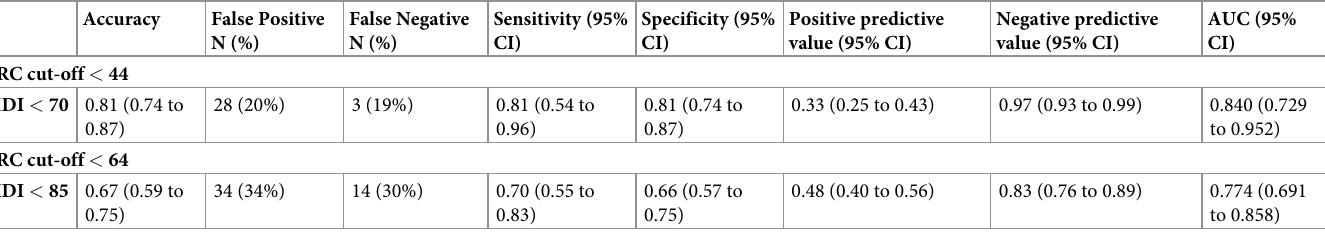
Table 2. Predictive values of ROC-determined cut-off PRC of 44 and 63 identifying children with MDI below 70 and below 85 at age 2 years, respectively.